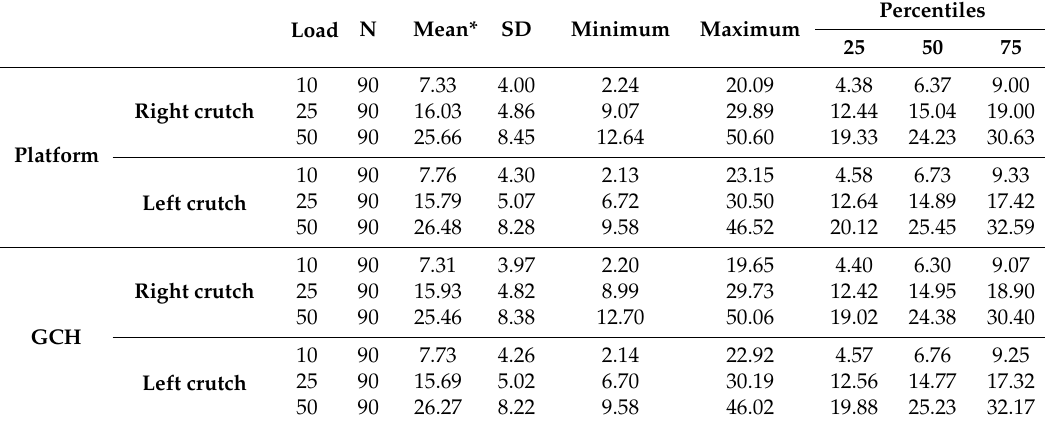
Table 2. Descriptive analysis of the Platform and GCH for each crutch and different